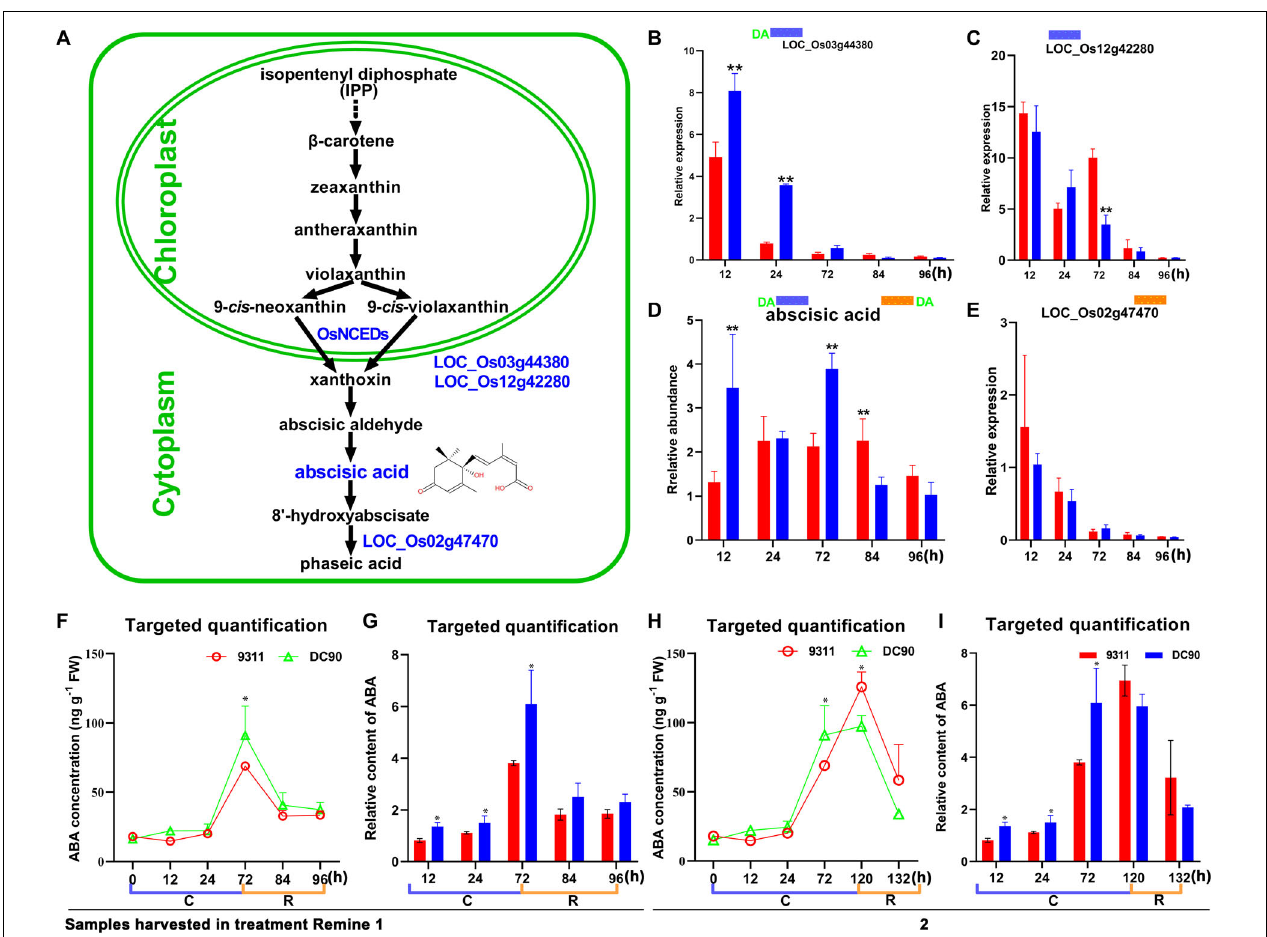
FIGURE 6 | Chilling- and/or recovery-induced DEGs and DAMs mapped to the abscisic acid metabolic pathway. (A) Abscisic acid metabolism pathway and mapped DEGs and DAMs. (B,C) Changes in LOC_Os03g44380 and LOC_Os12g42280 in 9311 and DC90, respectively. (D) Changes in abscisic acid in 9311 and DC90. (E) Changes in LOC_Os02g47470 in 9311 and DC90. (F,G) The concentrations and relative contents of ABA determined by targeted quantification under chilling and recovery treatment (0–96 h, Regime 1 in Figure 1A ), respectively. (H,I) The concentrations and relative contents of ABA determined by targeted quantification under chilling and recovery treatment (0–132 h, Regime 2 in Figure 1A ), respectively. The bar plots in (B–E) represent the metabolites with relative abundance alterations at certain timepoints in response to chilling (blue bar at the top) or recovery (orange bar at the top) treatment. The plot of transcripts or metabolites with the green letters DA to the left of the blue bar or to the right of the orange bar represent transcript or metabolite members of discriminatory DEGs/DAMs that play key role in differentiating the chilling tolerance capacity of 9311 and DC90. The black and dashed arrows in (A) represent overall upstream/downstream relationships and conversion catalyzed by multiple steps in the related pathways, respectively. *, ** in (B–I) . Significant at P ≤ 0.05 and 0.01 levels according to Student’s t test,